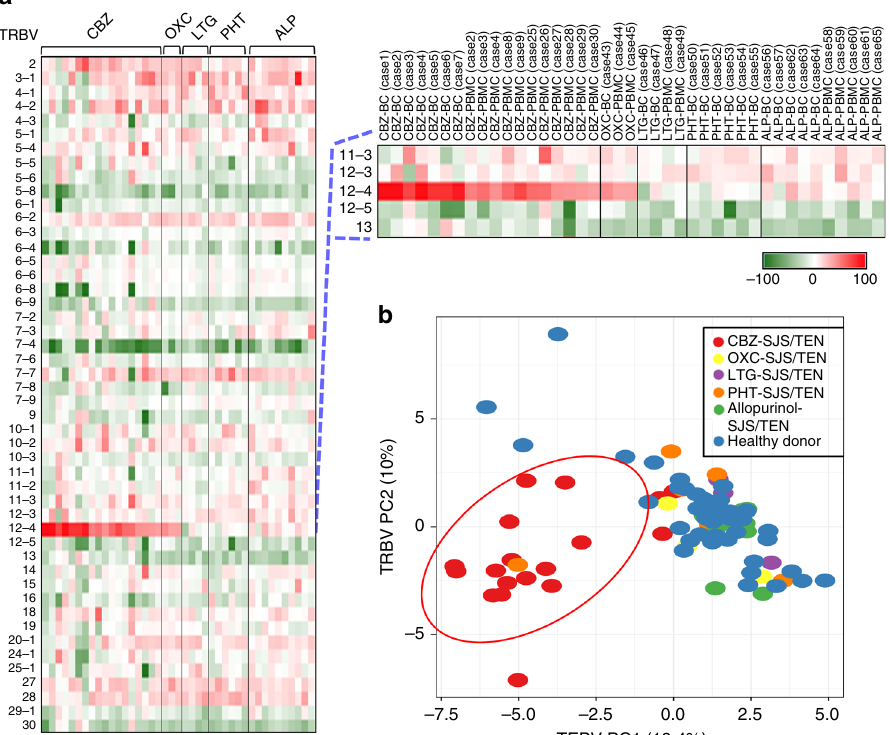
Fig. 1 Preferential TCR usage in blister cells and PBMC from patients with SJS/TEN. The PBMC and blister cells were isolated from patients with SJS/TEN caused by carbamazepine (CBZ; n = 18), oxcarbazepine (OXC; n = 3), lamotrigine (LTG; n = 4), phenytoin (PHT; n = 6), or allopurinol (ALP; n = 10). The expression pro fi les of TCR repertoire in the samples were analyzed by next-generation sequencing. a Heatmaps display the expression values of the TRBV genes from each sample, which were normalized to the mean values of the corresponding gene of the healthy donors ’ PBMC ( n = 44), respectively. The de fi nition of TRBV and TRBJ was based on the IMGT (ImMunoGeneTics) database. b Principal component analysis (PCA) of TRBV gene usage across samples from patients ( n = 41) with SJS/TEN caused by different drugs, and healthy donors ( n =